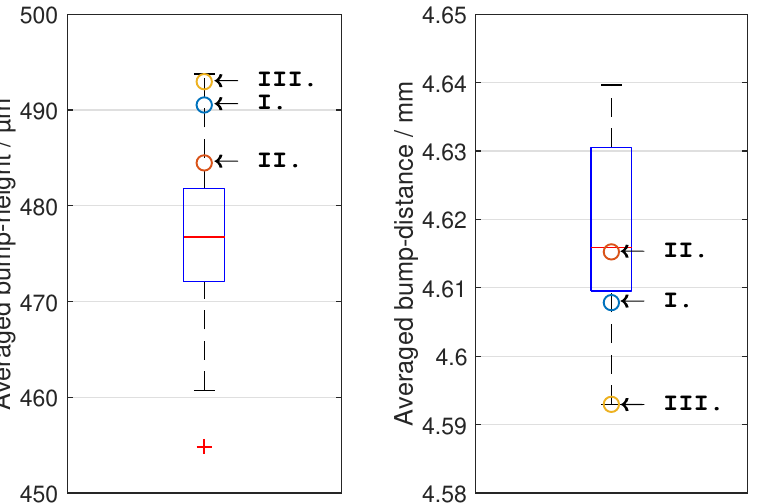
Figure 3. Bump heights and bump distances with median (red line), the range from the 25th to the 75th percentile (box), the range from the minimum to the maximum (dashed line) and the statistical outlier (red